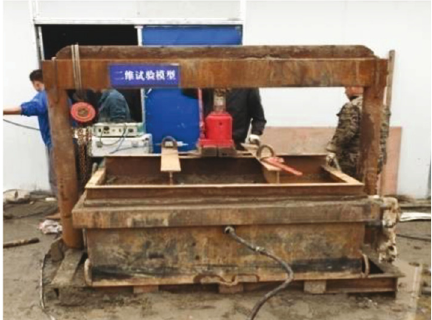
Figure 10: Design and image of the 2D experiment